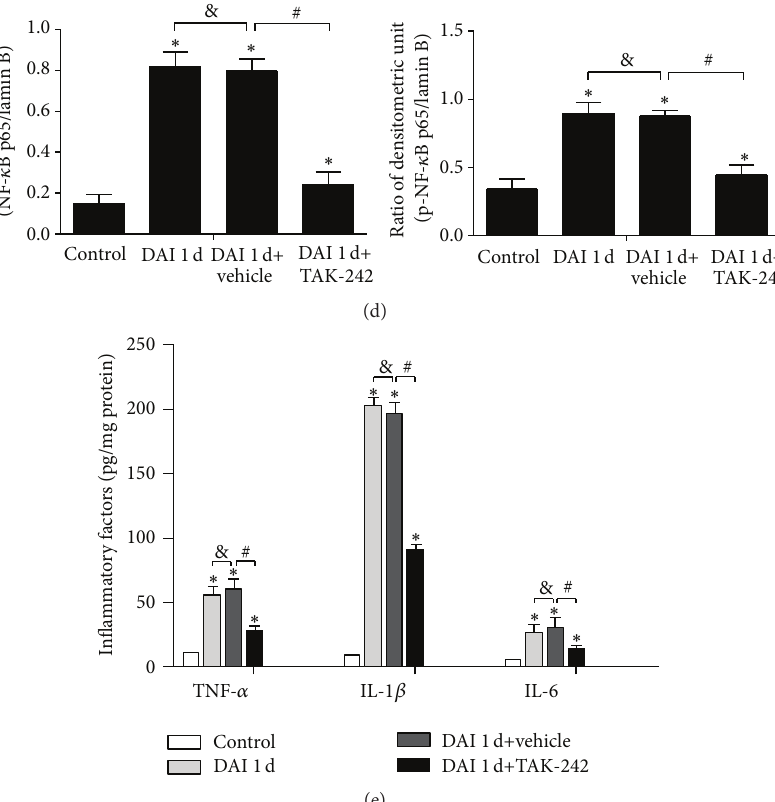
Figure 9: TAK-242 significantly downregulated the expression of signalling molecules downstream of TLR4 and reduced inflammatory factor levels. (a) The expression of several signalling molecules, including TLR4, MyD88, TRIF, IRF3, and IFN- 𝛽 , in the control, DAI 1d, DAI 1d+vehicle, and DAI 1d+TAK-242 groups, was measured via western blotting. (b) The bar graphs show the results for TLR4, MyD88, TRIF, IRF3, and IFN- 𝛽 expression, as determined via western blotting. (c) Western blotting analysis was performed to examine the expression of NF- 𝜅 B and phospho-NF- 𝜅 B in nuclear extract from the control, DAI 1d, DAI 1d+vehicle, and DAI 1d+TAK-242 groups. (d) The bar graphs show the results for NF- 𝜅 B and phospho-NF- 𝜅 B expression in the nuclear extract. The expression of lamin B was used as an internal control. (e) The levels of inflammatory factors, including TNF- 𝛼 , IL-1 𝛽 , and IL-6, were measured via ELISA in rat cortices in the control, DAI 1 d, DAI 1d+vehicle, and DAI 1d+TAK-242 groups. Data are presented as the mean ± SD ( 𝑛 = 6 ; ∗ 𝑝 < 0.05 , compared with control group; # 𝑝 < 0.05 , & 𝑝 > 0.05 , compared with DAI 1d+vehicle